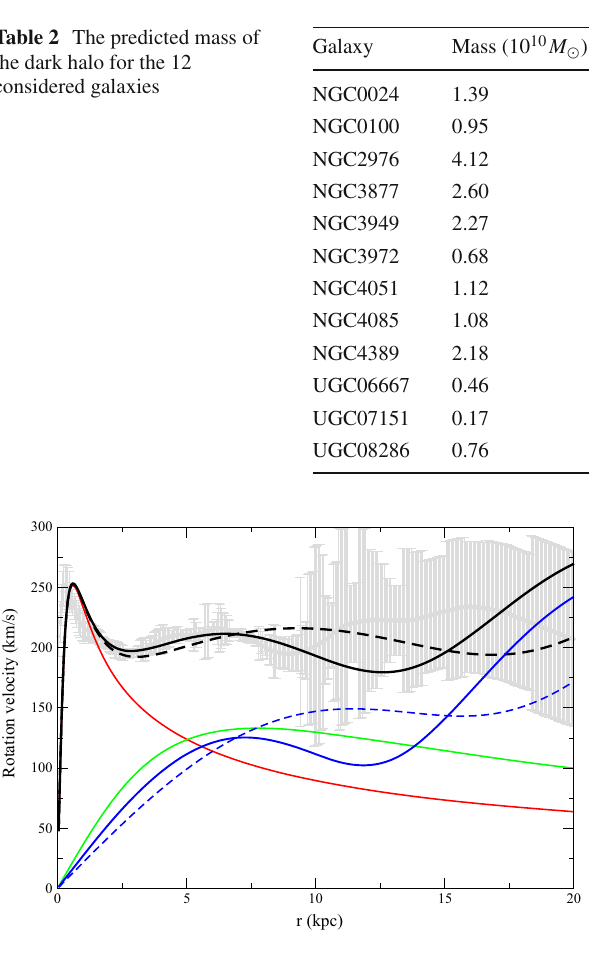
Fig. 7 The Milky Way rotation curve. The baryonic contributions are represented by the red line (bulge) and green line (disk). The blue lines are the dark matter contribution (solid: R = 6 . 9 kpc; dashed: R = 10 kpc). The black lines are the resultant rotation curves (solid: R = 6 . 9 kpc; dashed: R = 10 kpc). The gray lines and error bars are the observational data obtained in